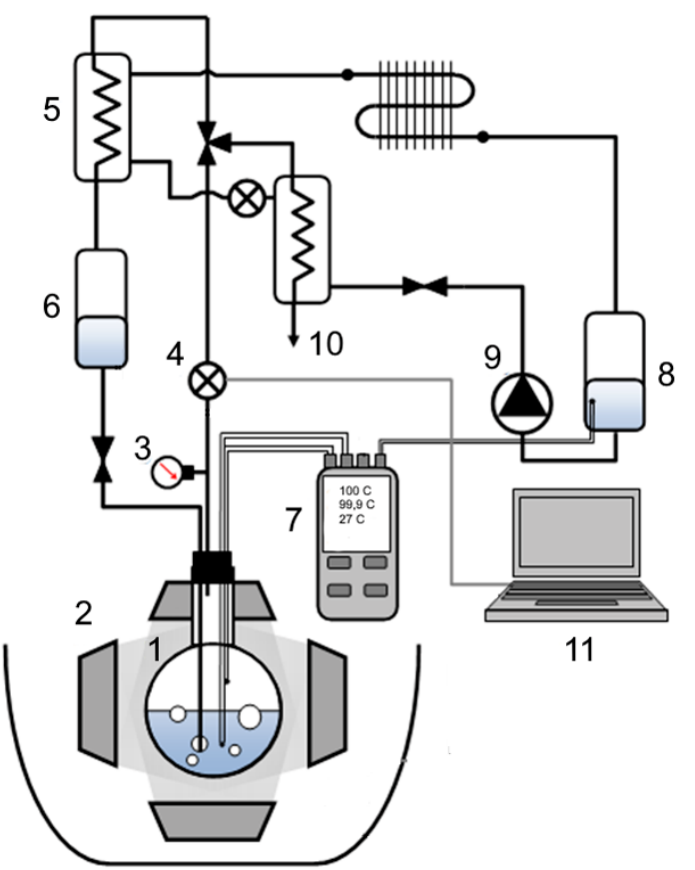
Figure 1. Scheme of the experimental system: 1—Steam generator; 2—Lamps; 3—Pressure gauge; 4—Flow meter; 5—Air condenser; 6—Condensate reservoir; 7—Data logger thermometer; 8—Water tank; 9—Circulation pump; 10—Water condenser;